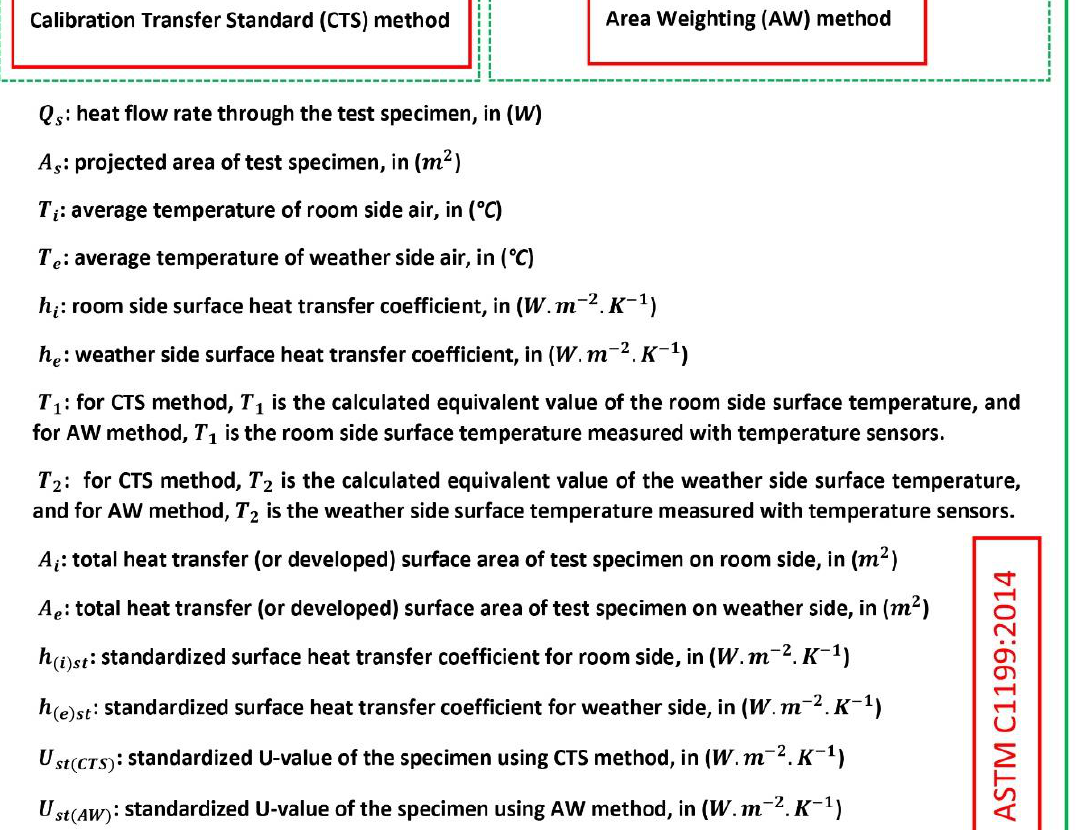
Figure 10. Summary of the standardization of the measured U-value following the standard ASTM C1199: 2014.